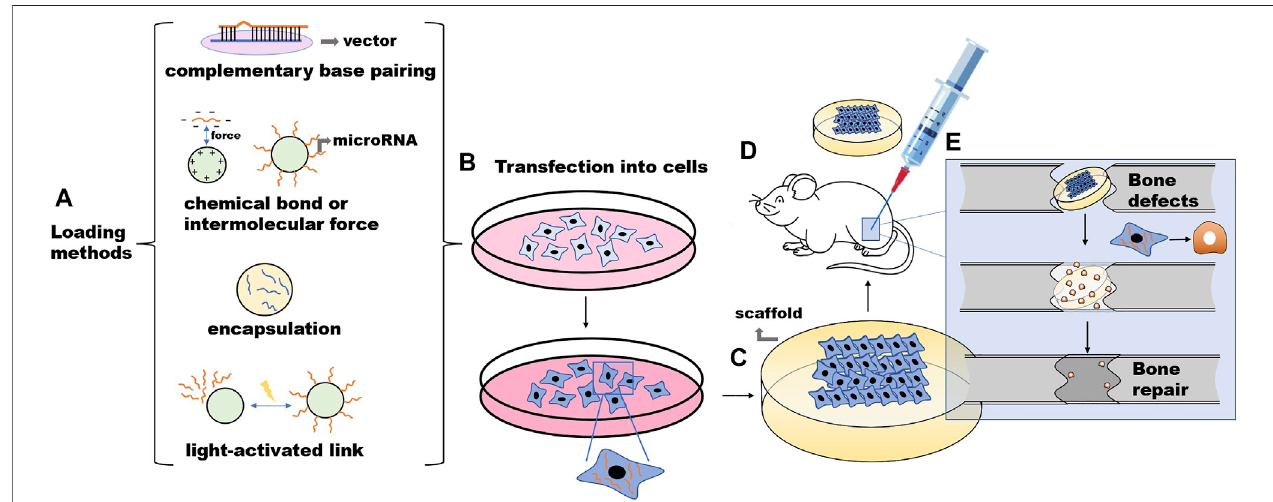
FIGURE 1 | The procession of the microRNA-involved bone tissue engineering. (A) Nonviral vectors and microRNA are combined in vitro. (B) Stem cells are cultured,expanded,andtransfected invitro . (C) Thecellsarethenseededontoascaffoldmaterial. (D) Thescaffoldwithcellsistransplantedtothecorrespondingdefect site of the animal model. (E) Cells continue to grow and reproduce in vivo and secrete extracellular matrix. With the gradual degradation of the materials, the new bone tissue fi nally replaces the scaffold materials to repair the structure and restore the function.